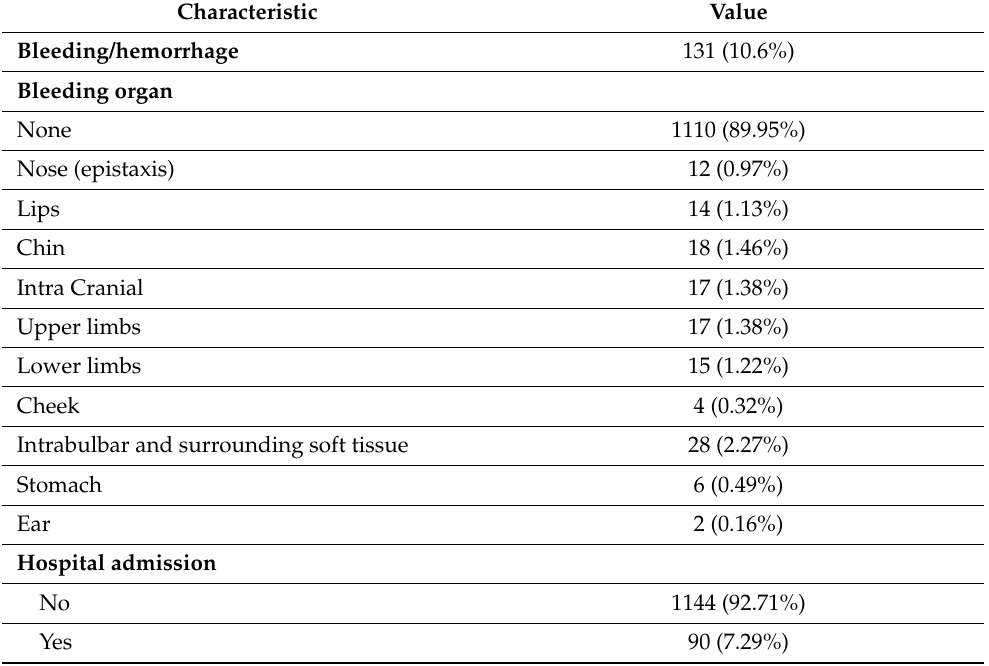
Table 2. Hemorrhaging and hospitalization of 1234 injured riders of E-bikes and P-scooters.